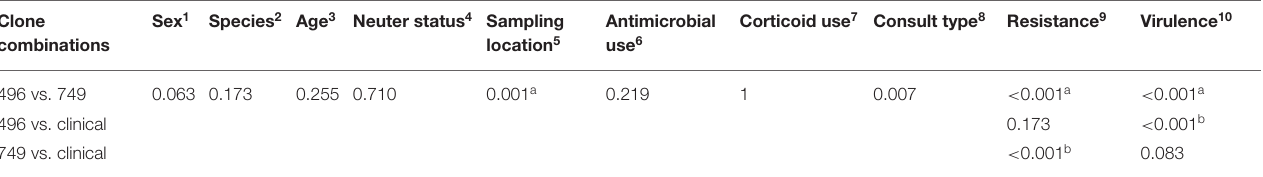
TABLE 3 | Epidemiological differences between most common colonizing methicillin-resistant Staphylococcus pseudintermedius clones and between these and nine clinical isolates using Fisher exact test; results are expressed as p -values for each pairwise comparison. Clone